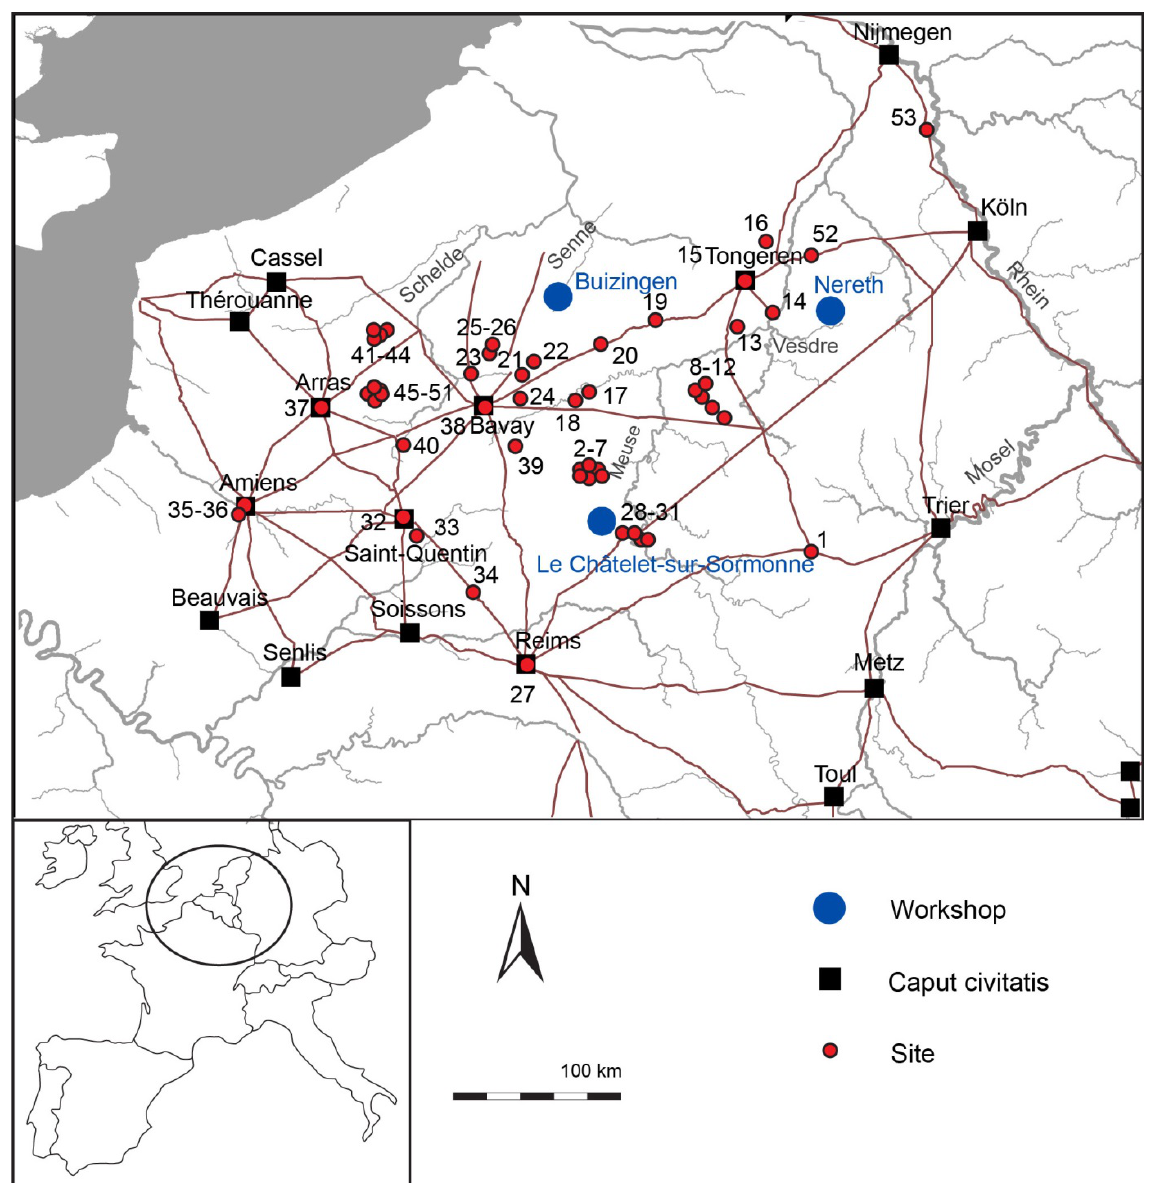
Figure 15: Sites with at least one whetstone fashioned from materials collected in the Rocroi Inlier. Belgium: 1. Arlon; 2-7. Matagne-la-Grande, Neuville, Treignes, Roly, Nismes, Fagnolle; 8-12. Hamois, Gesves, Ohey, Ciney, Jemelle; 13. Wanze; 14. Jupille-sur-Meuse; 15. Tongeren; 16. Neerharen; 17. Thy-Le-Bauduin; 18. Aiseau-Presles; 19. Taviers; 20. Liberchies; 21. Nimy; 22. Houdeng; 23. Pommeroeul; 24. Fontaine-Valmont; 25-26. Silly, Ghislenghien. France: 27. Reims; 28-31. Saint-Laurent, Ville-sur-Lumes, Warcq, Remilly-les- Pothées; 32. Saint-Quentin; 33. Urvillers; 34. Laon; 35-36. Amiens, Pont-de-Metz; 37. Arras; 38. Bavay; 39. Sains-du-Nord; 40. Les-Rues-des-Vignes; 41-44. Villeneuve d’Ascq, Templemars, Seclin, Noyelles-lès-Seclin; 45-51. Brebières, Lauwin-Planque, Dechy, Guesnain, Flines-lez-Râches, Dourges, Pecquencourt. The Netherlands: 52. Heerlen. Germany: 53.